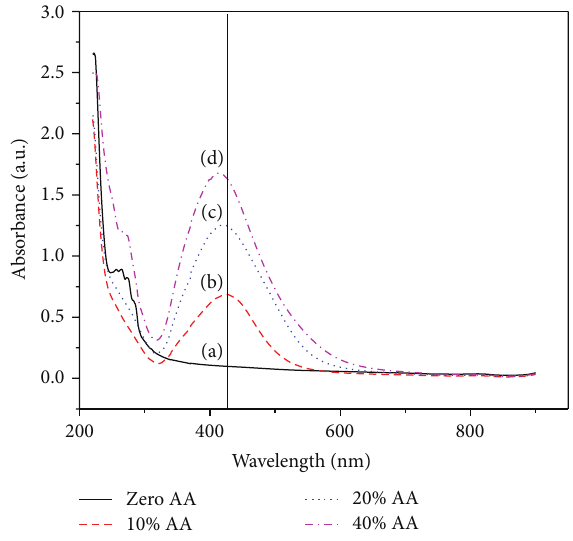
Figure 1: UV-Vis spectrum of PAA and AgNO 3 after addition of sodium tricitrate and NaBH 4 with different concentration of AA: 0 (a), 10 (b), 20 (c), and 40 (d) in 𝜇